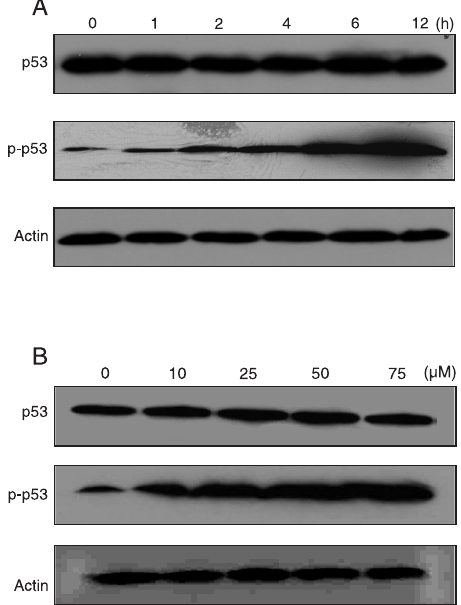
Figure 4. Enhanced serine phosphorylation of p53 in HT-29 cells by treatment with curcumin. A , Cells were incubated in serum- free medium overnight and then further incubated for 0, 1, 2, 4, 6, and 12 h in the presence of 50 µM curcumin. B , Cells were incubated in serum-free medium overnight and then further incu- bated for 6 h in the presence of 0, 10, 25, 50, and 75 µM curcumin, respectively. Equal amounts of cell lysates were resolved by SDS- PAGE and analyzed by Western blot using specific antibodies. The blots were re-probed with anti-actin antibody to confirm equal pro- tein loading.